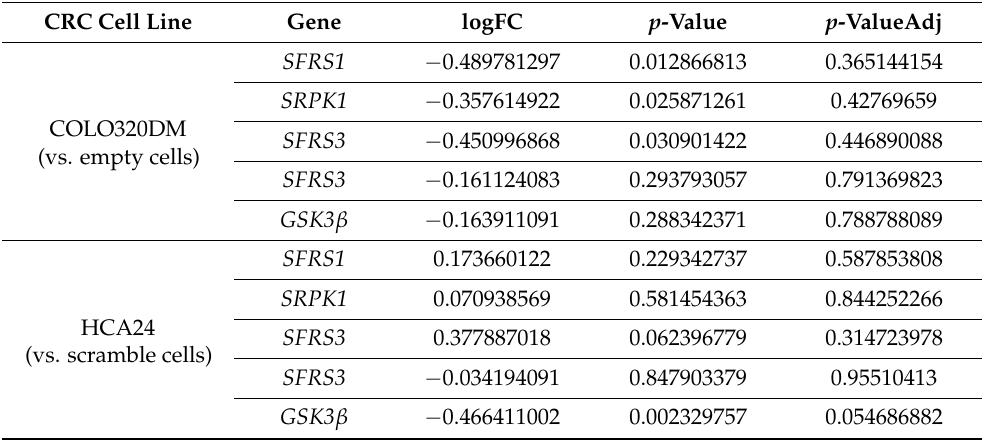
Table 1. Expression of splicing factors to be directly involved in RAC1b splicing. cDNA microarray data generated on the two ESRP1-modulated cell lines, COLO320DM and HCA24 were analyzed for expression of RAC1b. COLO320 DM, logFC = 1.45, p -Value Adjusted = 0.003; HCA24, logFC = − 1.88, p -Value Adjusted = 2.77 × 10 -05